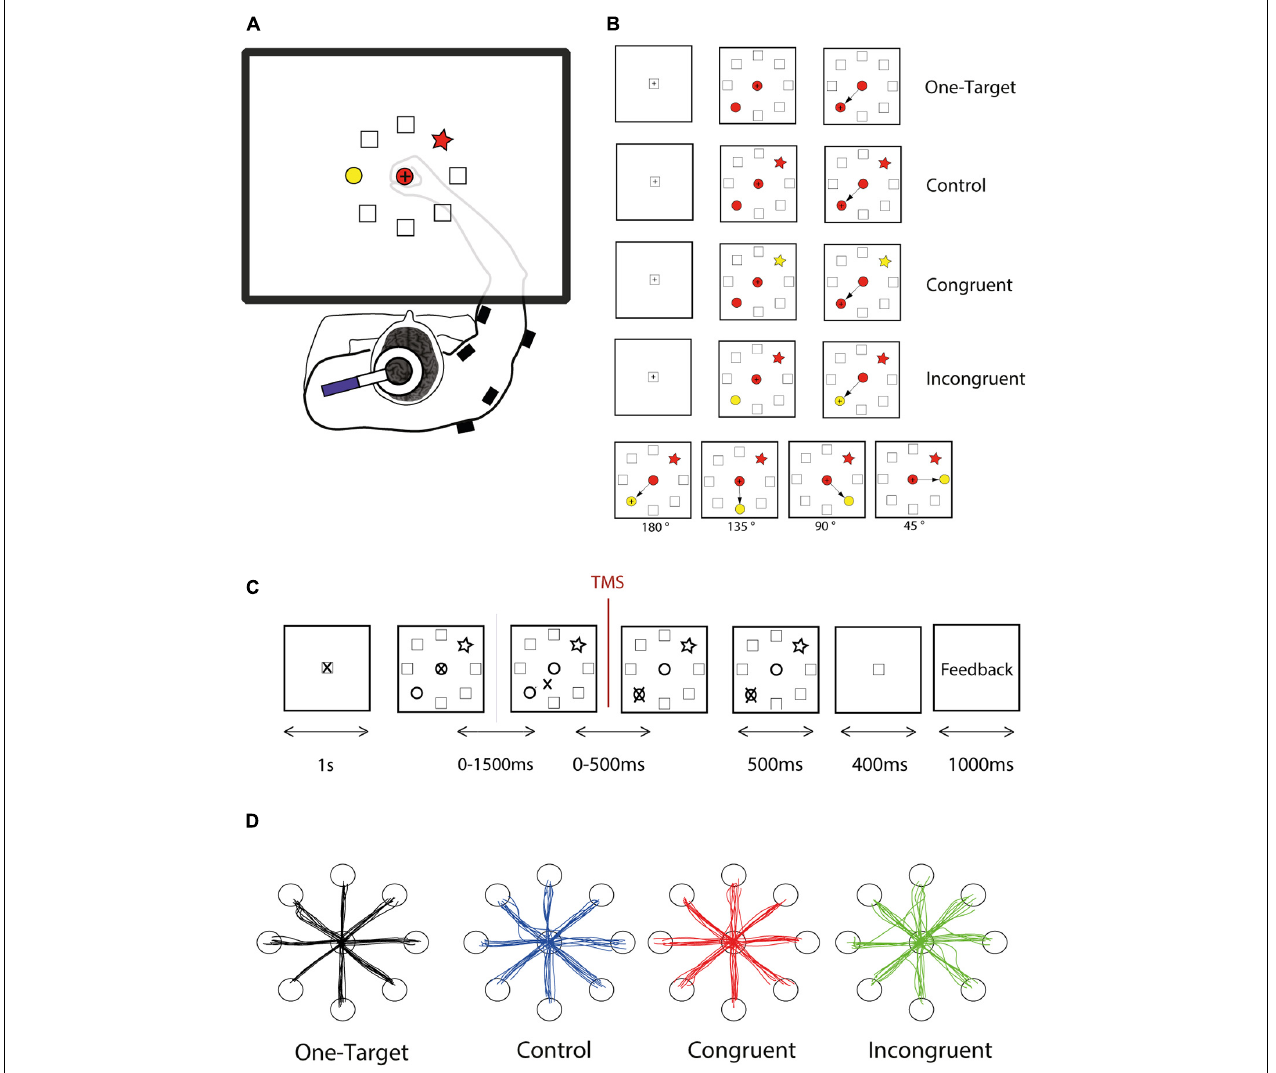
FIGURE 1 | Experimental design. (A) The subject responded to the task by moving a cursor on a digitizing tablet. Stimuli and cursor feedback are projected onto a mirror placed between the table and the monitor. Single-pulse transcranial magnetic stimulation (TMS) was applied over left primary motor cortex, and EMG activity was measured thanks to wireless electromyographic surface electrodes attached to the main muscle groups of the right upper arm. (B) The task follows a shape-matching rule, and color dimension is an irrelevant feature of the stimuli. However, shapes and colors were assembled to form different cognitive situations, of three different levels of difficulty. For each cognitive condition, the target could be located in every one of 8 positions arrayed in a circle, and the distractor could be spaced from 45 to 180 ◦ . (C) The DSLT task began (after a 1,000-ms rest period during which the cursor rests in the home position) with the simultaneous presentation of one central shape and the peripheral target and distractor. The subject had up to 1,500 ms to initiate the movement and up to 500 ms to reach the correct target and stay inside for 500 ms. Then a positive or negative visual feedback, depending on the response accuracy appeared for 1,000 ms. (D) Examples reach trajectories in one-target, Control, Congruent, and Incongruent conditions from one